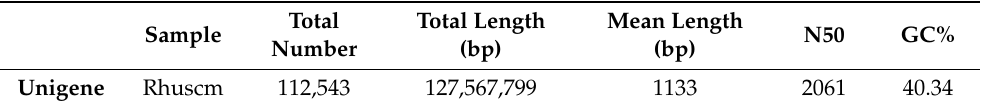
Figure A6. DEGs in photosystem. Squares indicate gall vs. LWG; circles indicate gall vs. LNG; triangles indicate LNG vs. LWG. Red color represents up-regulation and green color represents down-regulation. The numbers within shaded shapes indicate the number of genes. There were six genes up-regulated and 62 genes down-regulated based on the comparison between gall vs. LWG, six genes up-regulated and 61 genes down-regulated based on the comparison between gall vs. LNG, two genes up-regulated based on the comparison between LNG vs. LWG. Most genes involved in photosynthesis were down-regulated in galls. Table A1. Statistics of